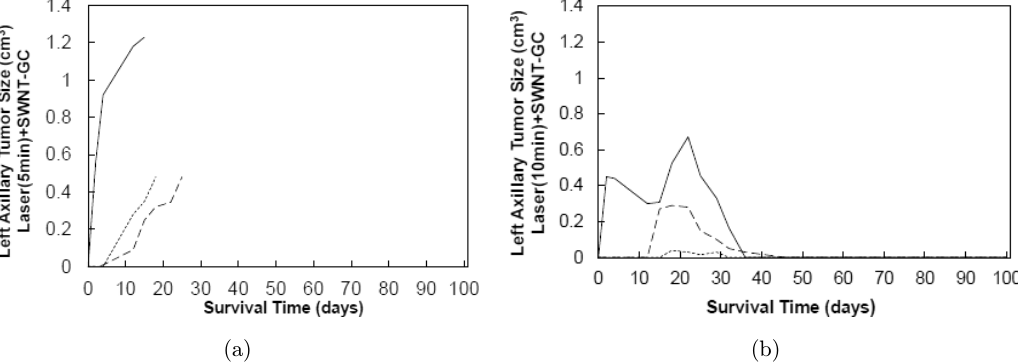
Fig. 4. Regression of metastatic tumors. Primary tumors in rats were treated 10 – 14 days after tumor inoculation, when tumor volume was approximately 0.5 cm 3 . Untreated metastatic tumors were measured twice per week. (a) Left axillary metastases of rats receiving SWNT – GC with 5 min of laser irradiation. (b) Left axillary metastases of rats receiving SWNT – GC with 10 min of laser irradiation. (c) Right axillary metastases of rats receiving SWNT – GC with 5min of laser irradiation. (d) Right axillary metastases of rats receiving SWNT – GC with 10 min of laser